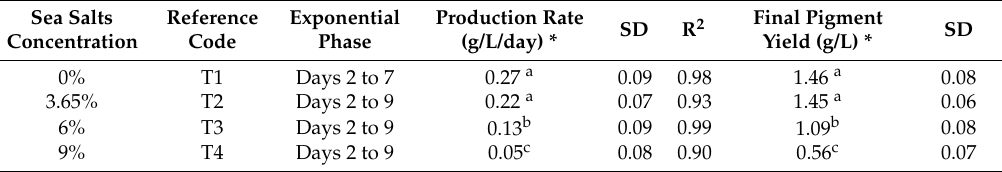
Table 4. Rate of pigment production and final pigment yield from T. albobiverticillius 30548 based on salinity percentage in the fermentation media (culture in PDB, 27 °C, initial pH 4.0, 200 rpm of agitation rate).